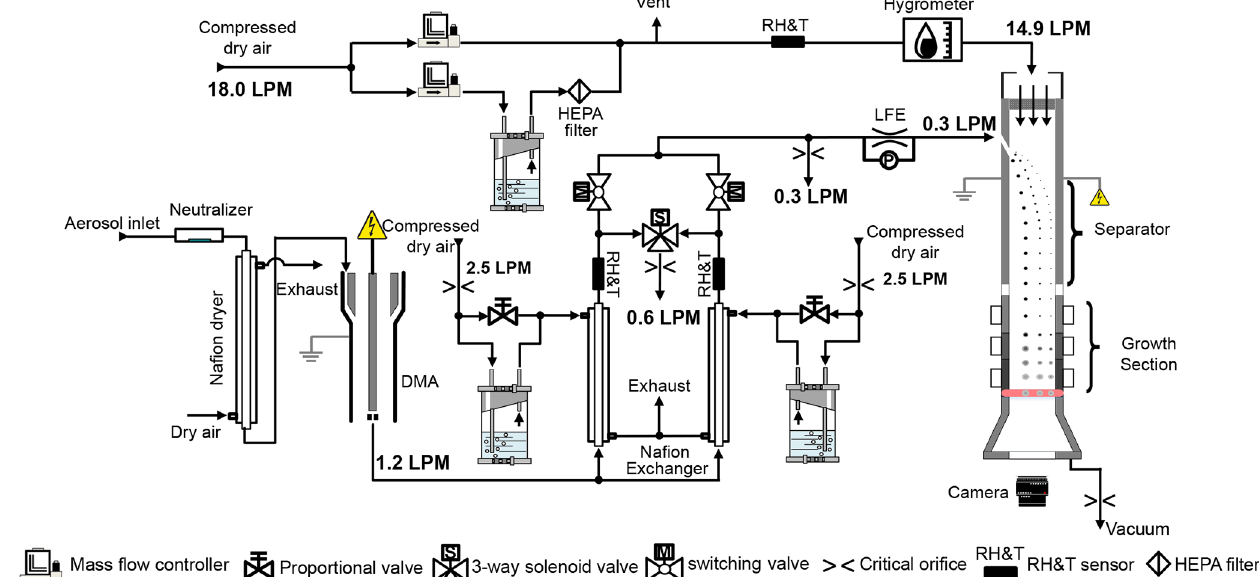
Figure 1. Schematic diagrams of dual-channel humidity-controlled fast integrated mobility spectrometer.